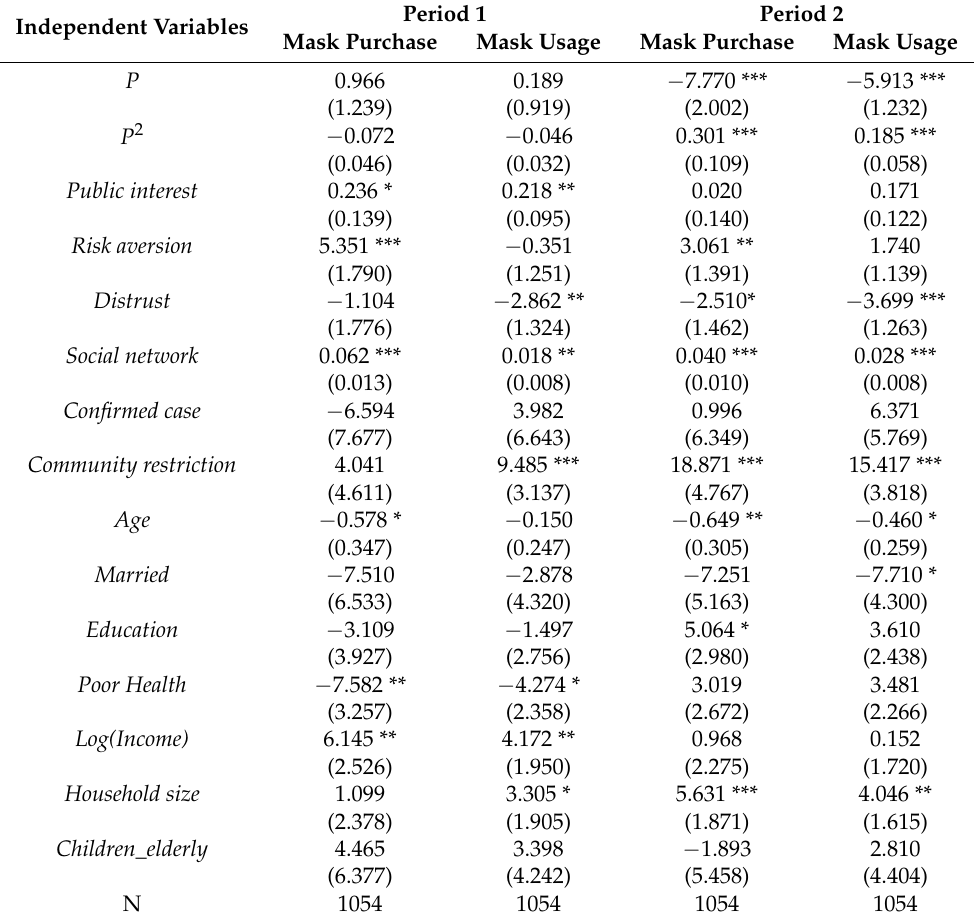
Table 3. Estimated unconditional marginal effects for purchase and usage for Period 1 and Period